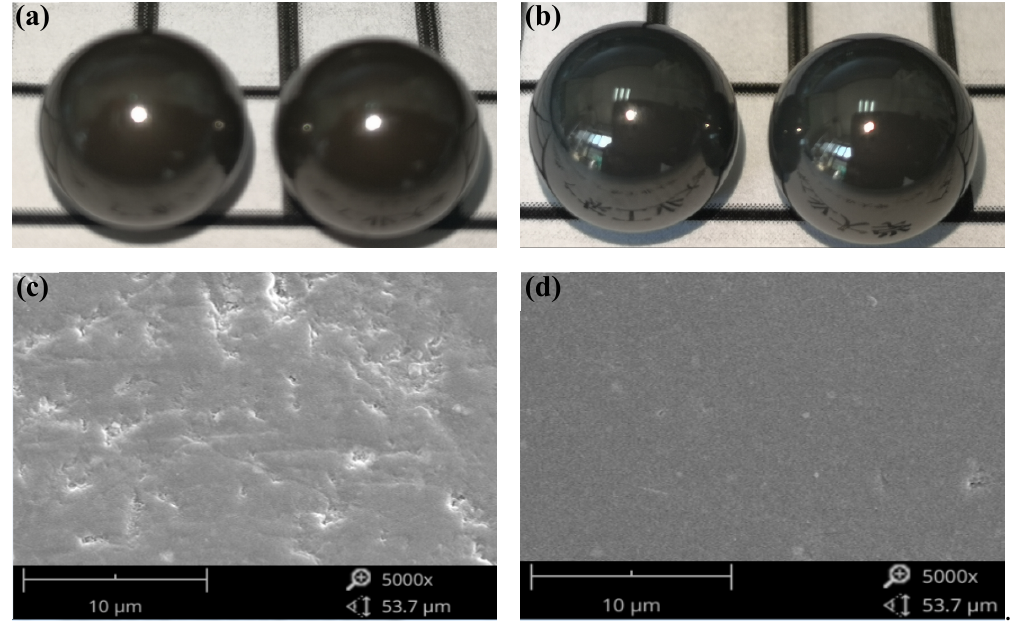
Figure 4. Optical images and micro morphologies of ceramic balls: ( a ) the ceramic balls before CMRF ( b ) the ceramic balls after CMRF (Test 2 and Test 7) ( c ) the micro morphology of unmachined surface ( d ) the micro morphology of polished surface (Test 6).